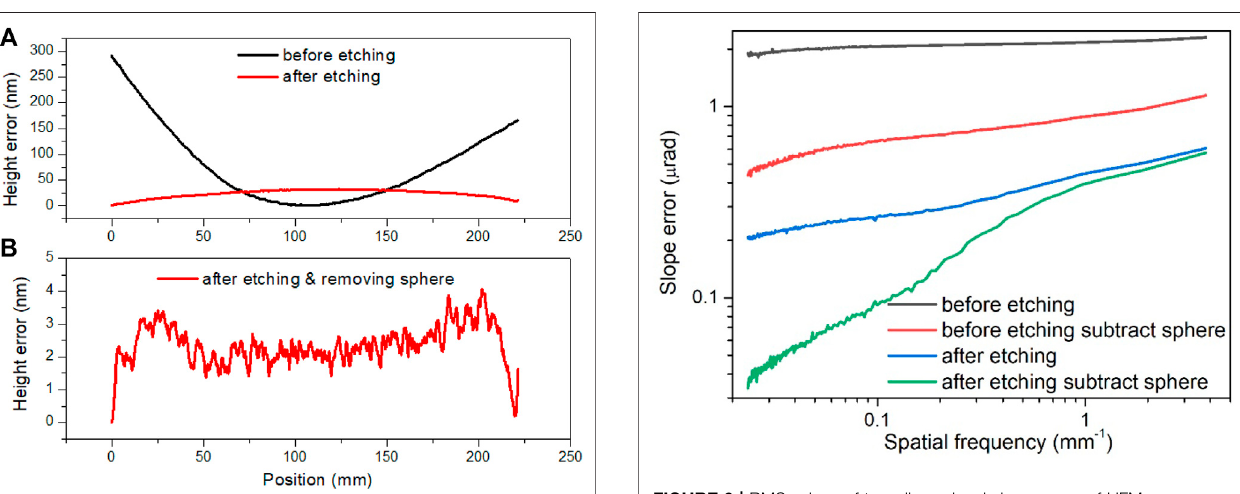
FIGURE7|(A) One-dimensionalheightpro fi lealongthelengthdirection of HFM before and after IBF. (B) Height error after IBF with the best- fi t sphere was subtracted.